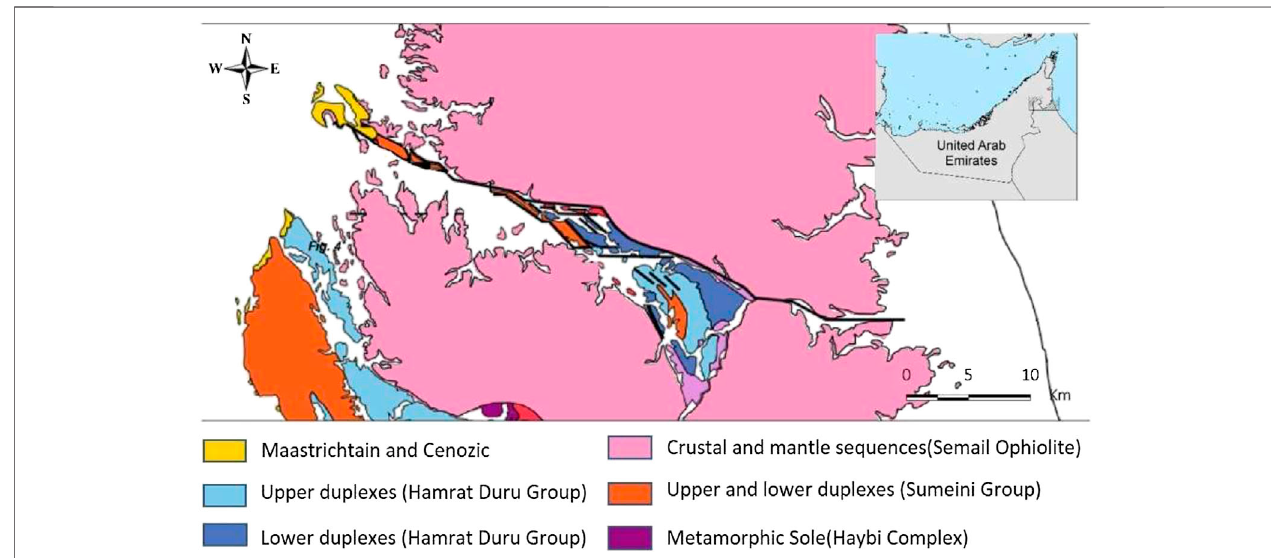
FIGURE 2 | Modi fi ed geological map of the Hatta region, updated after Glennie et al. (1974).